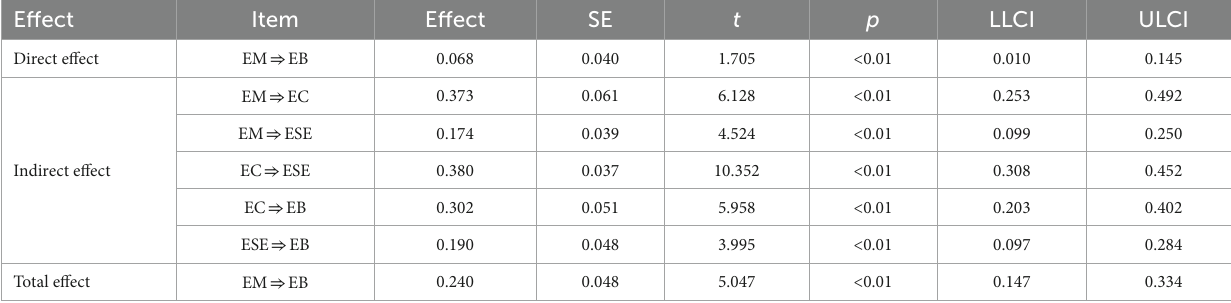
TABLE 4 Analysis of regression relationship among